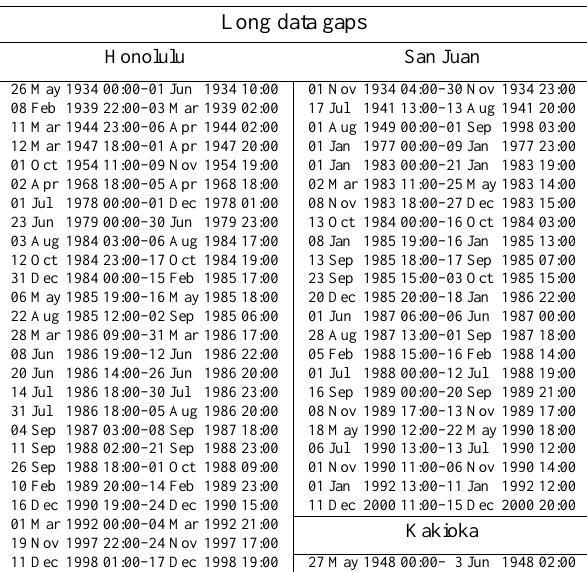
Table 2. Data gaps longer than 3 days for HON, SJG and KAK. All gaps in HER and CTO were shorter than 3 days. Dates are in universal time